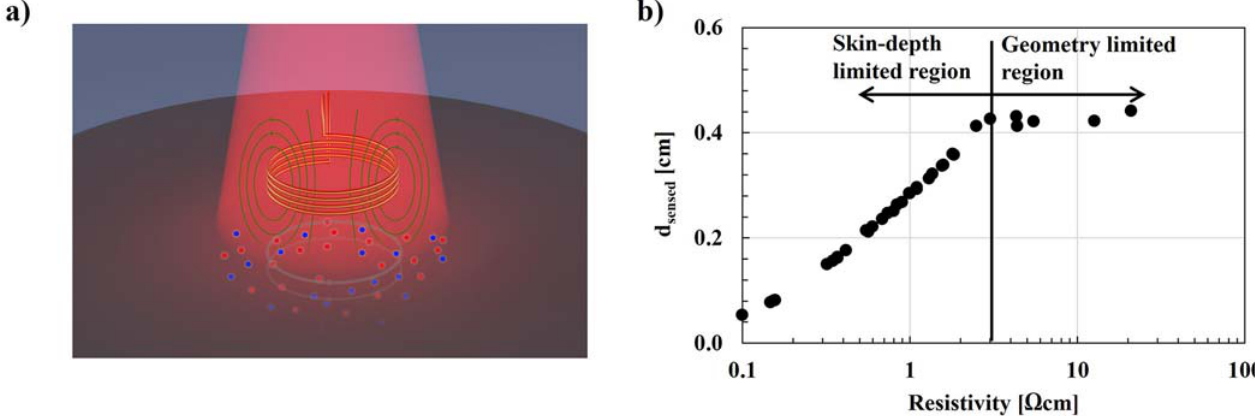
Fig. 1. (a) Schematic illustration of the laser e-PCD measurement method. (b) Effective depth of sensitivity of the RF-coil as measured on thick